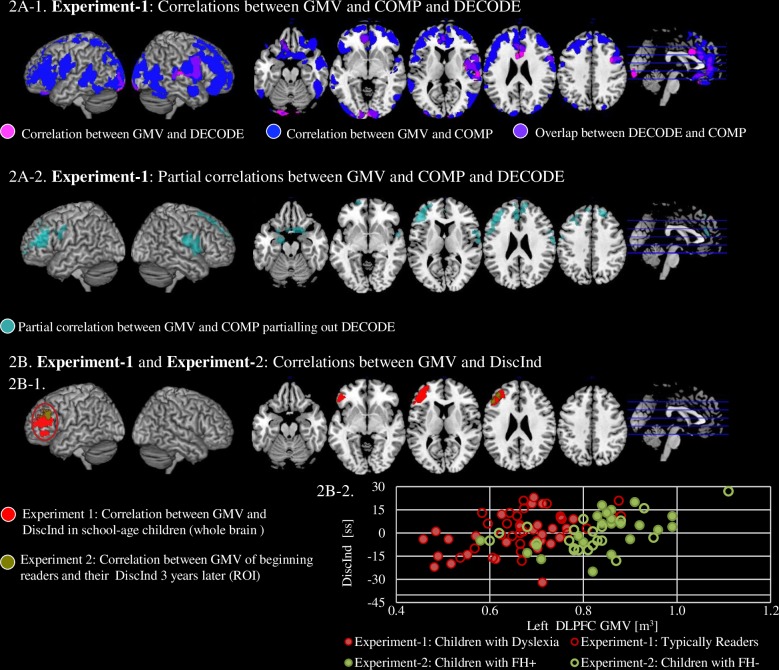
The neural correlates of decoding, reading comprehension and DiscInd.A. Experiment-1. Association between GMV and behavioral measures of decoding (DECODE) and reading comprehension scores (COMP). A-1. Association between GMV with COMP (blue) and DECODE (pink). A-2. Association between GMV with COMP partialling out DECODE (cyan). There were no regions that correlated between GMV and DECODE when COMP was partialled out. B. Experiment-1 and Experiment-2. Association between GMV and DiscInd, i.e., a score subtracting DECODE from COMP. B-1. The cluster that shows association between GMV and DiscInd in school-age children from Experiment-1 whole brain analysis is shown in red. In Experiment-2, the cluster that shows association between GMV of beginning readers and DiscInd 3 years later within the cluster obtained from Experiement-1 using ROI small volume correction is shown in green. B-2. Mean values extracted from the clusters in B-1 are plotted as scatterplots to show that the positive relationships between DiscInd scores and left dorsolateral prefrontal cortex (DLPFC) GMV are not driven by children with dyslexia in Experiment-1 (red full circle) or from the children with a family history of dyslexia in Experiment-2 (green full circle).